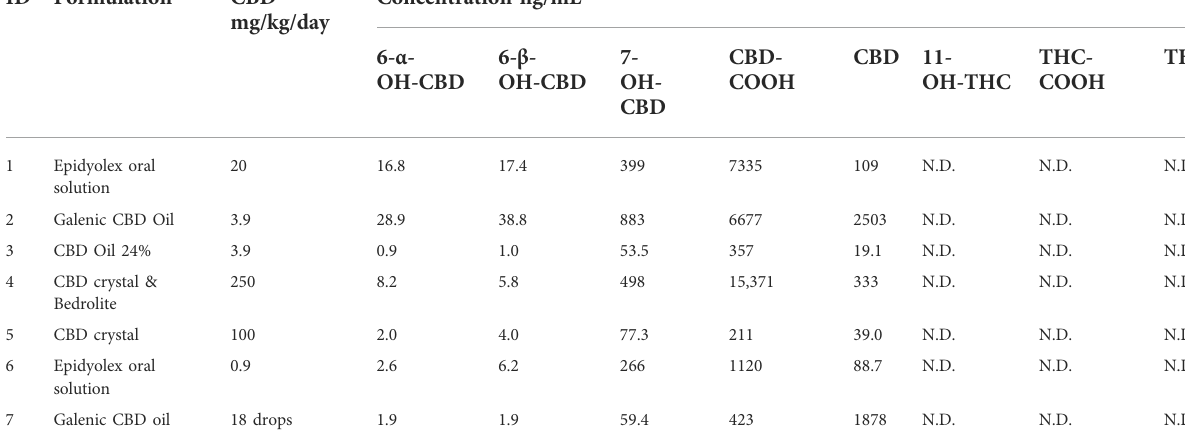
TABLE 5 Formulations, doses, and concentrations of CBD, THC, and their respective metabolites in patients ’ blood samples collected with the VAMS technique after CBD therapy. ID